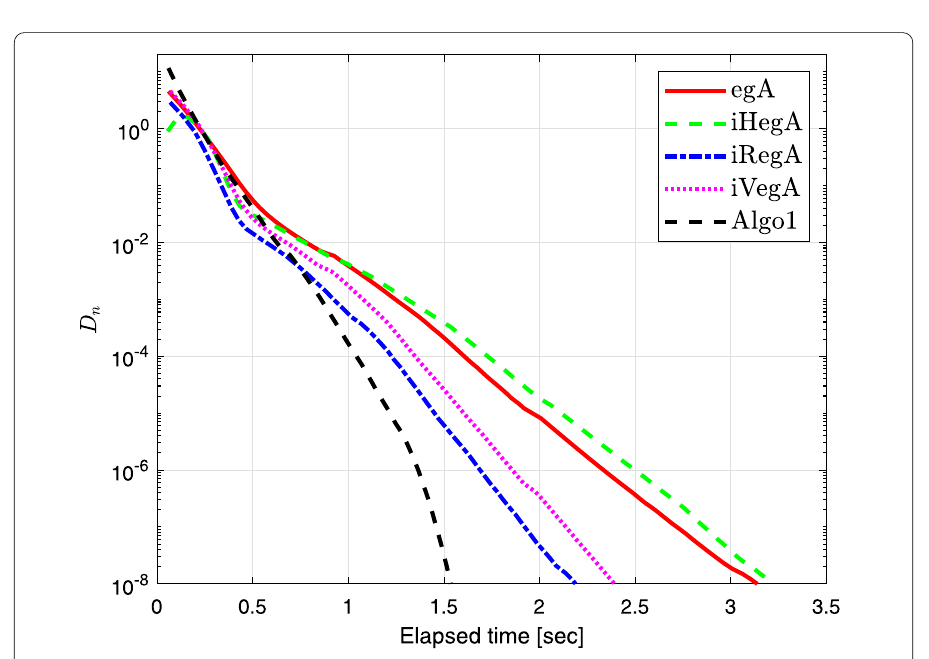
Figure 9 Example 5.3 when x 0 = (1,2,3,4,5) T : the number of iterations is 88, 81, 61, 56, 50,